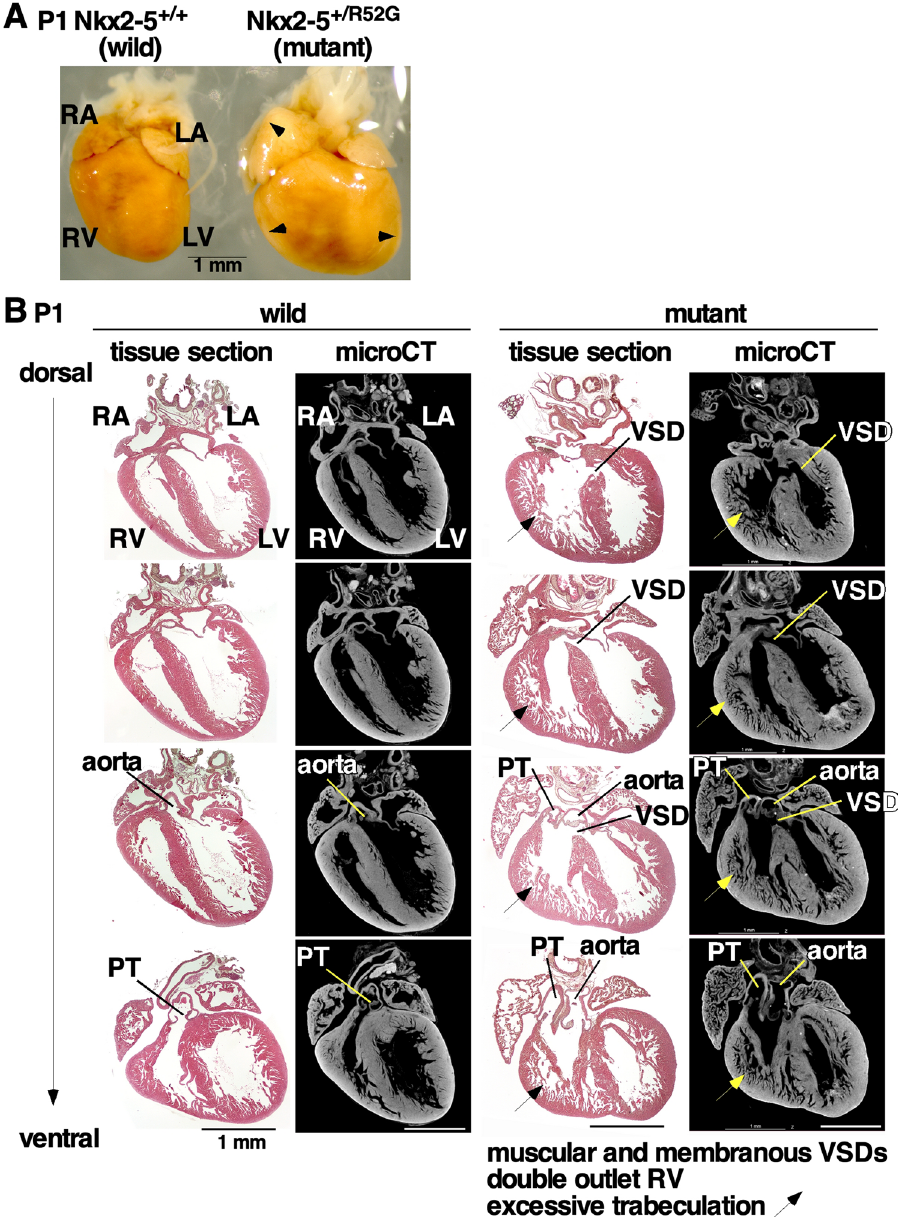
Figure 1. Representative cardiac anomaly in postnatal day 1 Nkx2-5 + /R52G mouse and control wild-type littermate. Control Nkx2-5 + / + (left) vs. Nkx2-5 + /R52G (right): ( A ) dissected hearts, ( B ) heart tissue sections and corresponding micro-computed tomography images. Excessive trabeculation in Nkx2-5 + /R52G is indicated by arrows. LA left atrium, LV left ventricle, PT pulmonary trunk, RA right atrium, RV right ventricle, VSD ventricular septal